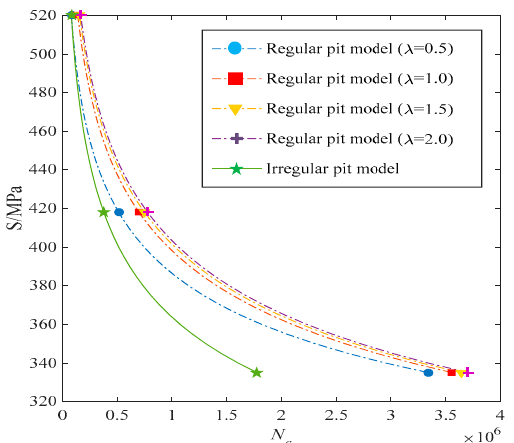
Figure 17. S-N curves of pre-corroded steel wire with mass loss rate of 2.5%.